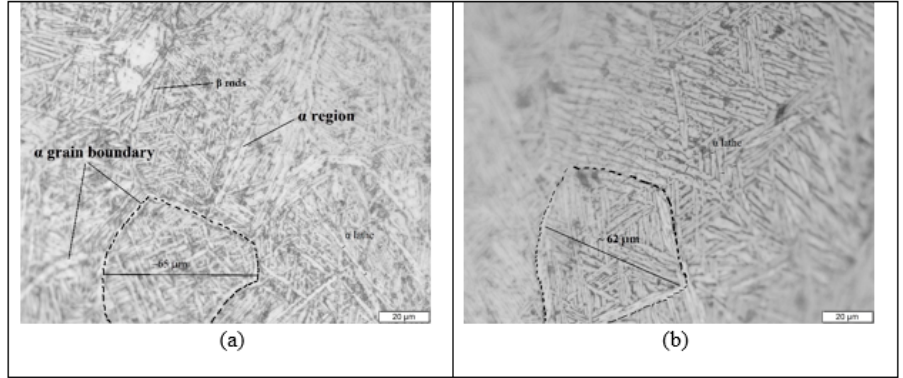
Figure 22. Optical microscopy of 30-mm-diameter and 5-mm-thick samples ( a ) with support and ( b ) without support.